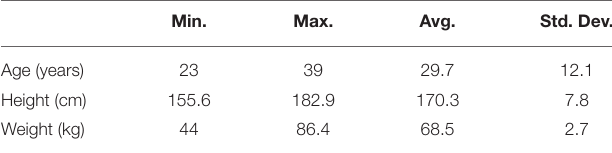
TABLE 1 | Information of 10 subjects involved in experiments (Min., Minimum; Max., Maximum; Avg., Average; Std. Dev., Standard Deviation). Min.